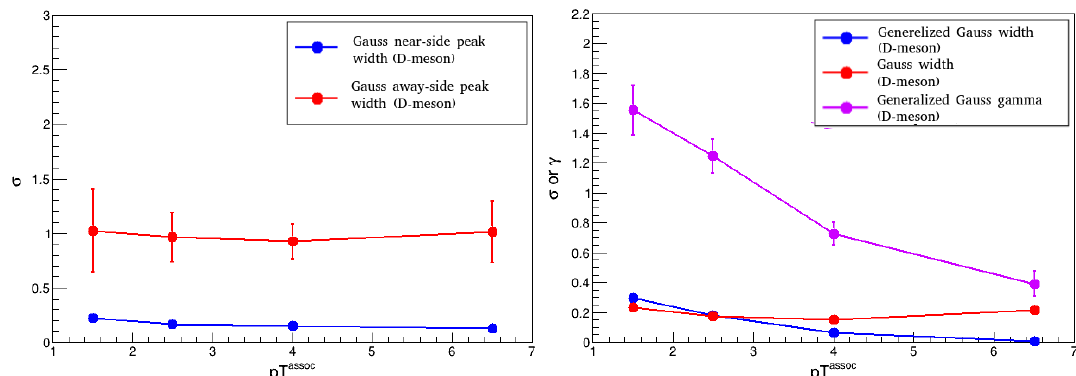
Figure 4. The peak width for Gaussian fitting (on the left side) and for generalized Gaussian fitting (on the right side) for D meson from the decay of the B meson for 5 < p trigger p assoc values. T